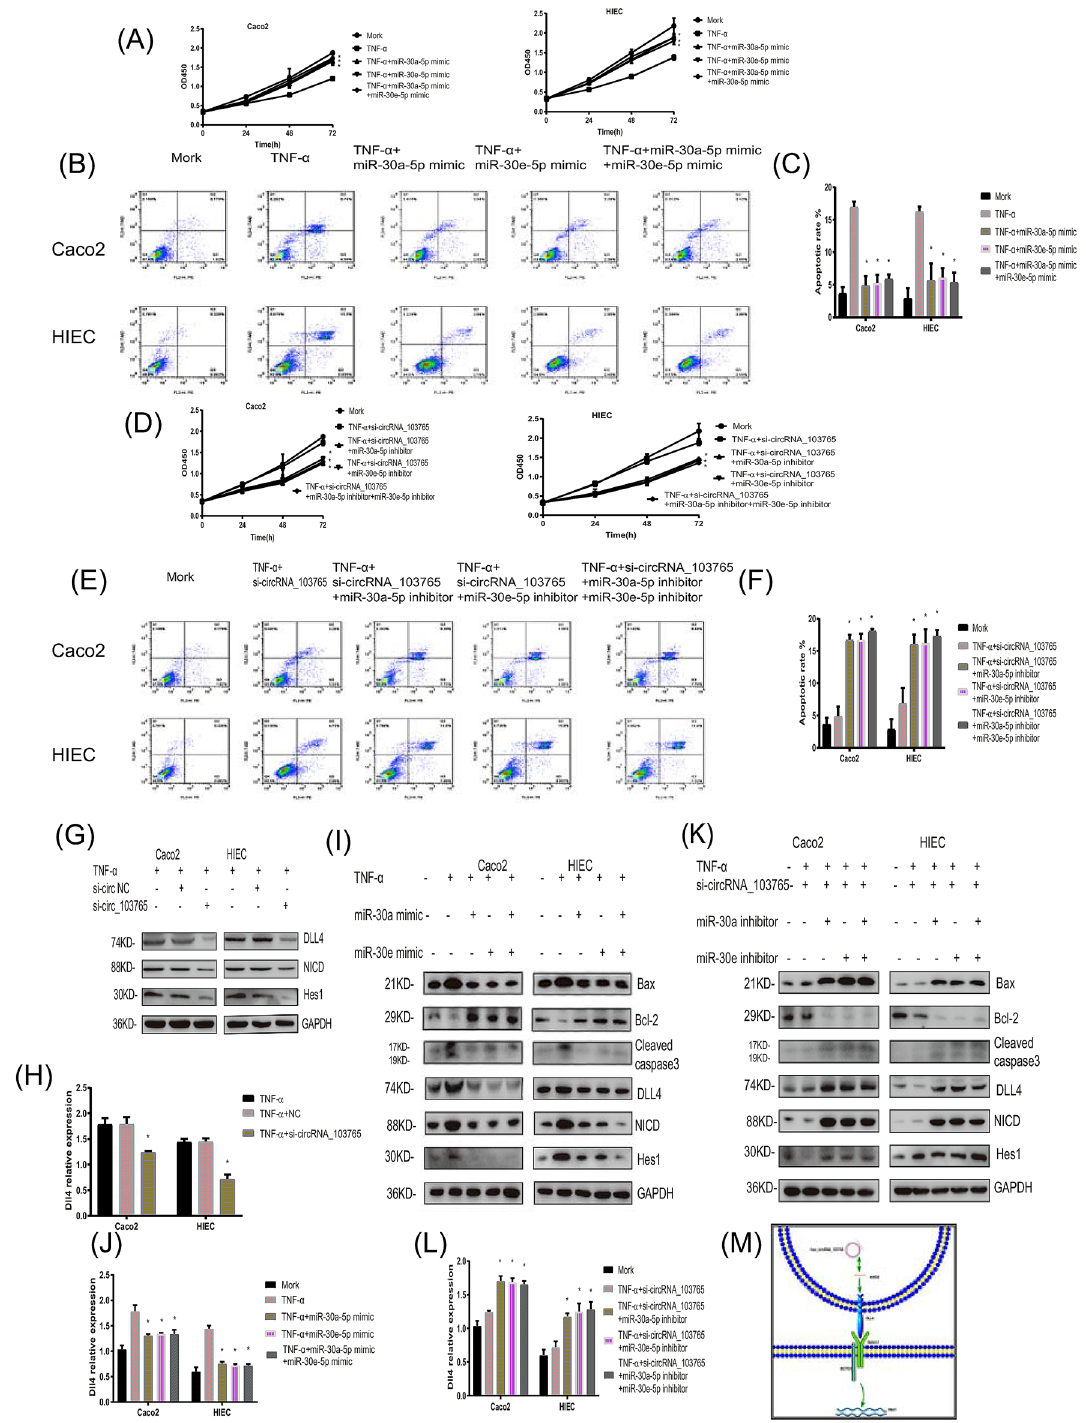
Figure 6. CircRNA_103765 promotes human intestinal epithelial cells proliferation and apoptosis through circRNA_103765/miR-30/DLL4 axis. ( A , D ) The cell proliferation was determined after transfection with indicated vectors, mimics or inhibitors at the indicated days. ( B , C , E , F ) Apoptosis rate was analysed by flow cytometry after transfection. ( G – L ) Relative expression of DLL4 and downstream cell cycle-related molecules and apoptosis-related molecules at protein level in cells transfected with indicated vectors, mimics or inhibitors was determined by western blot. ( M ) Schematic diagram of how circRNA_103765 sponge miR-30 mediated DLL4 expression. *P <